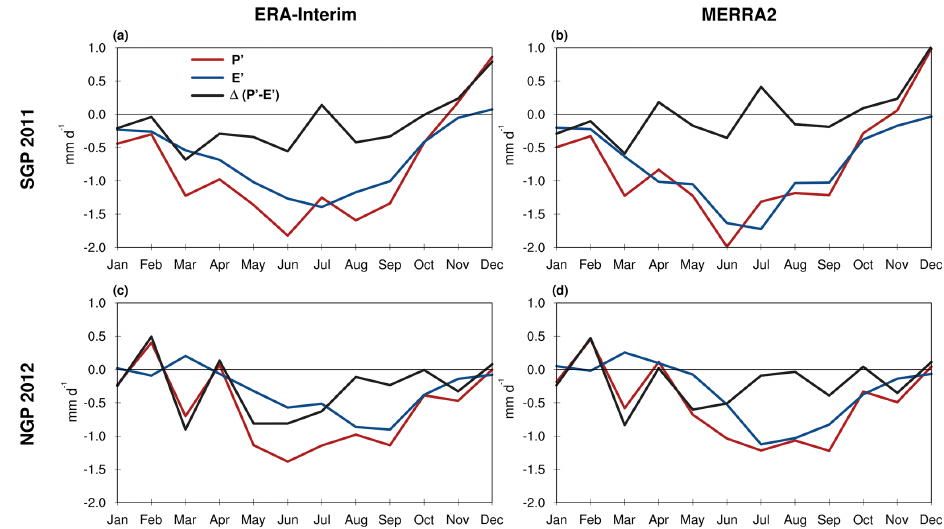
Figure 2. Annual cycle of precipitation (red), evapotranspiration (blue), and P − E (black) anomalies (mmd − 1 ) averaged over the SGP in 2011 ( a , b ) and the NGP in 2012 ( c , d ) using ERA-Interim ( a , c : 1979–2018) and MERRA2 ( b , d : 1980–2018) reanalysis.